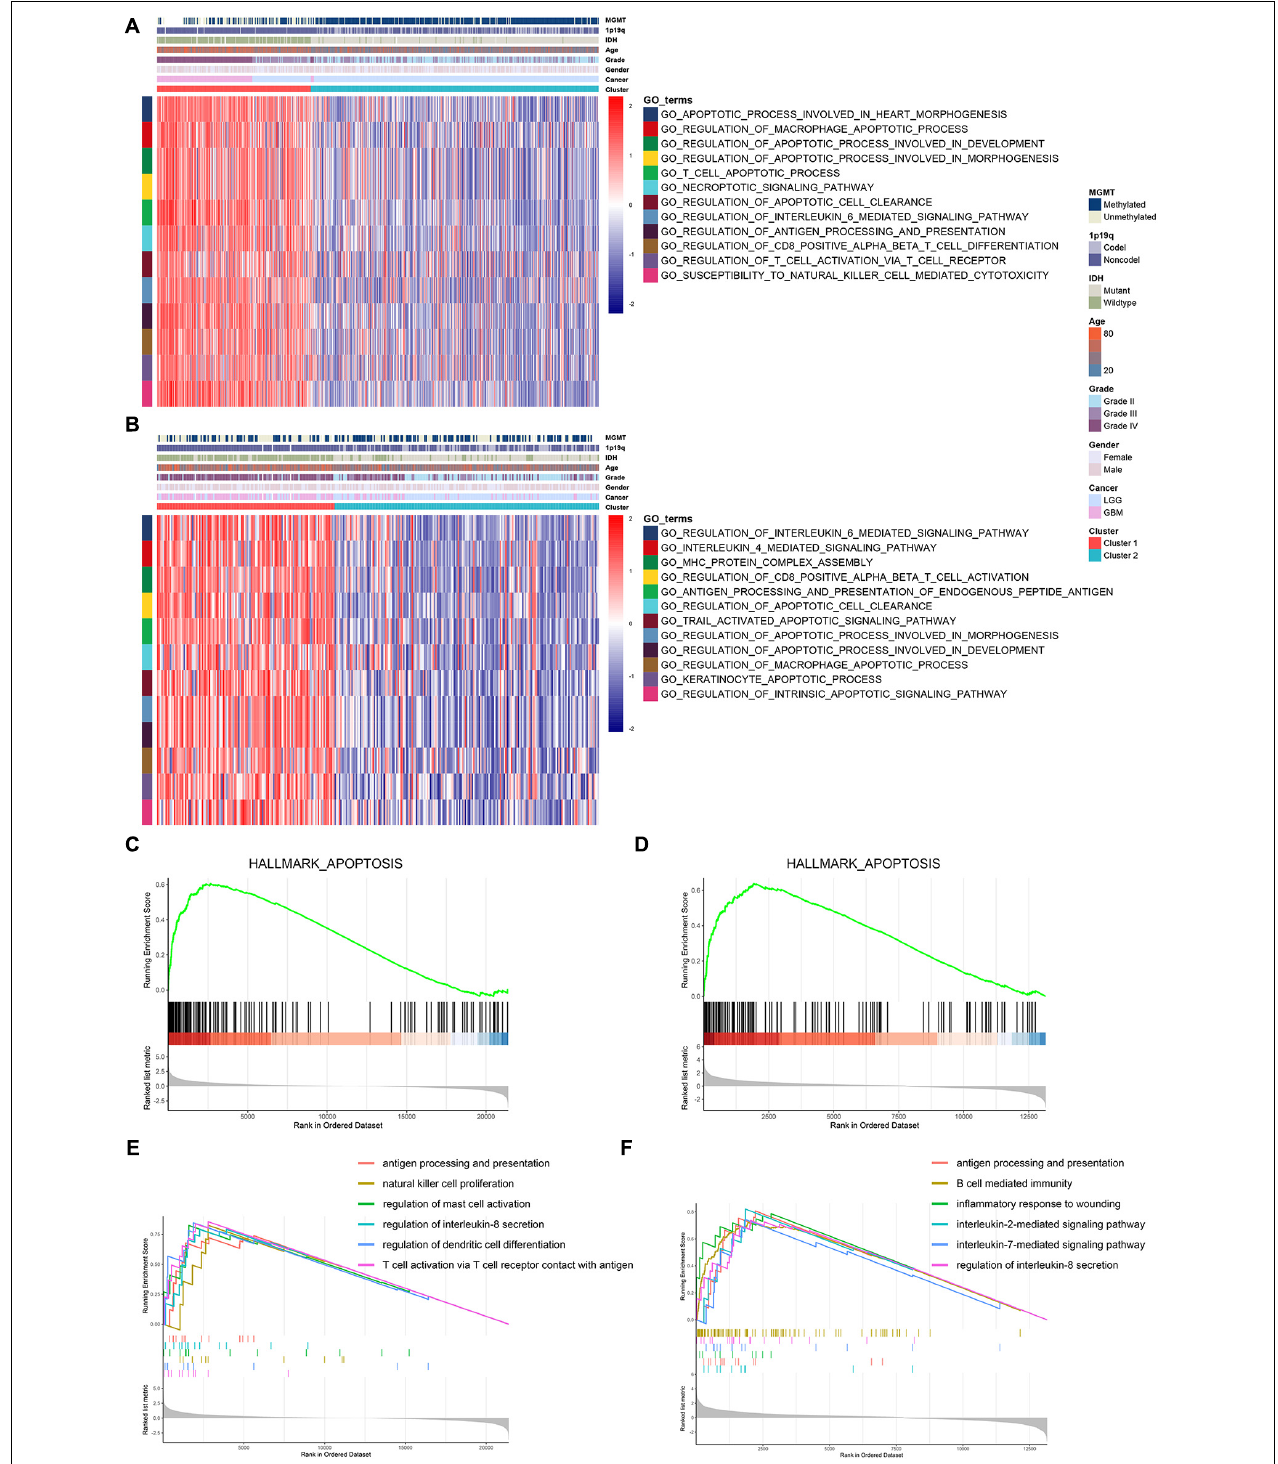
FIGURE 3 | Cluster 1 was enriched with apoptotic and immune processes. (A,B) GSVA analysis revealed the enrichment of apoptotic and immune pathways in cluster 1 and cluster 2 in TCGA (A) and CGGA (B) datasets. (C,D) GSEA analysis of hallmark gene sets regarding differentially expressed genes between cluster 1 and cluster 2 in TCGA (C) and CGGA (D) datasets. (E,F) SEA analysis of differentially expressed genes between cluster 1 and cluster 2 in TCGA (E) and CGGA (F) datasets.